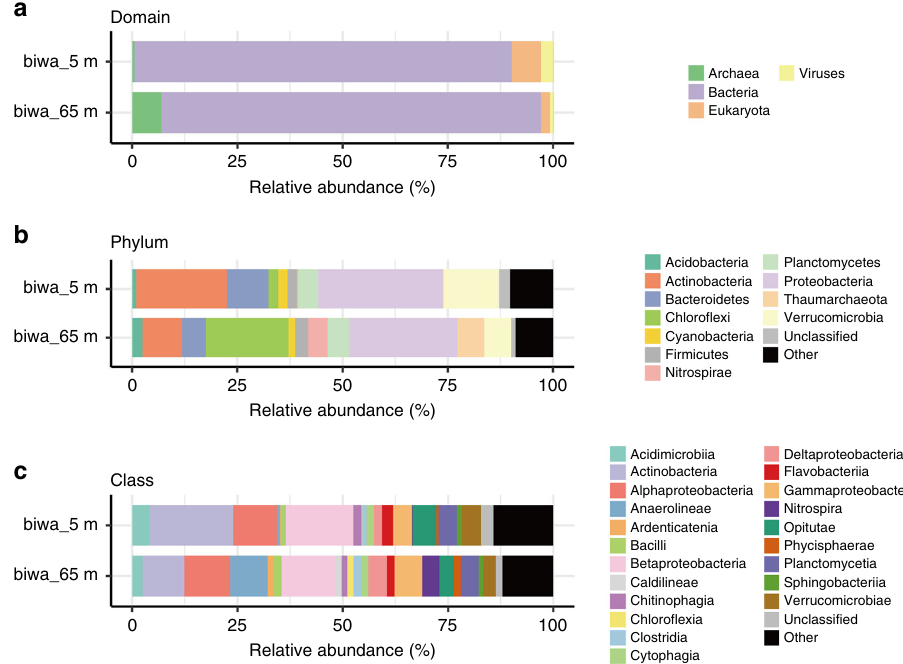
Fig. 1 Phylogenetic distribution of CCS reads. Estimated relative abundances at the a domain, b phylum, and c class levels are shown. Eukaryotic and viral reads are ignored, and groups with <1% abundance are grouped as ‘ Other ’ in b ,